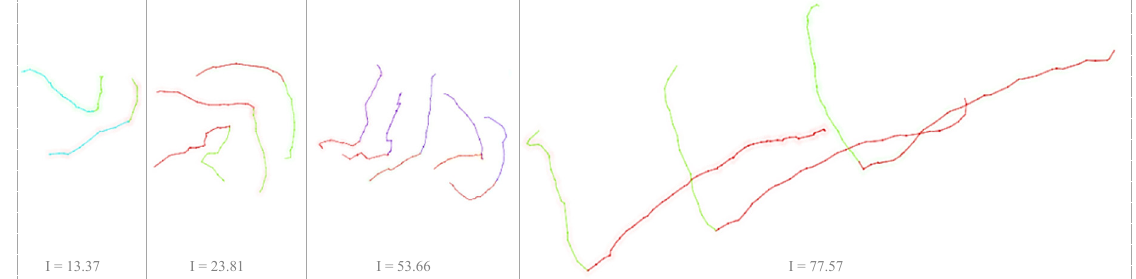
Figure 8. Illustration of the interestingness score based on individual movement patterns: it increases from left to right. The different colors represent different cluster assignments of each single movement/sequence element.